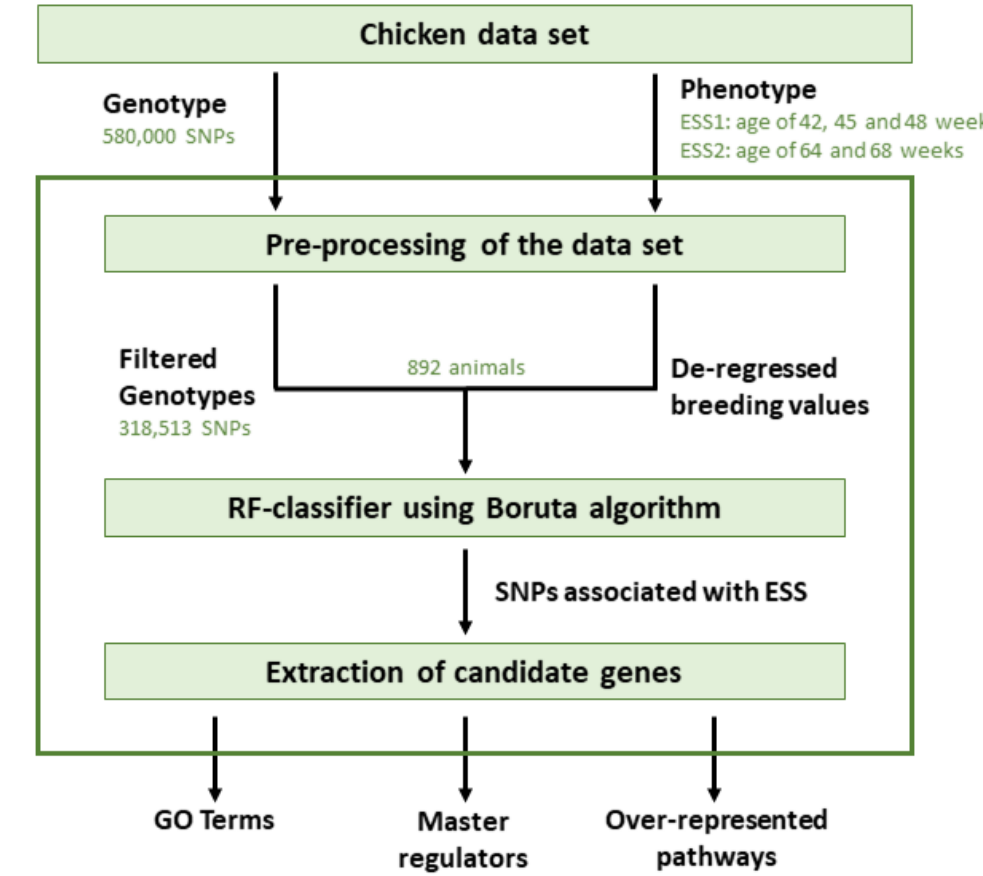
Figure 1. Flowchart of the analysis applied in this study (ESS, Eggshell